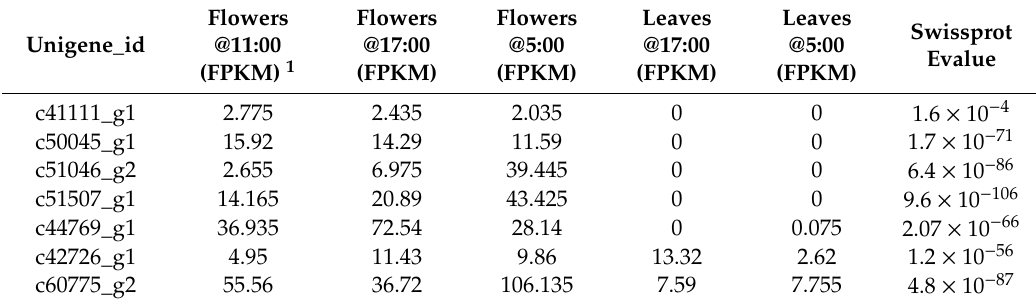
Table 1. Unigenes of SWEET homologs preferentially expressed in flowers identified from a transcriptome